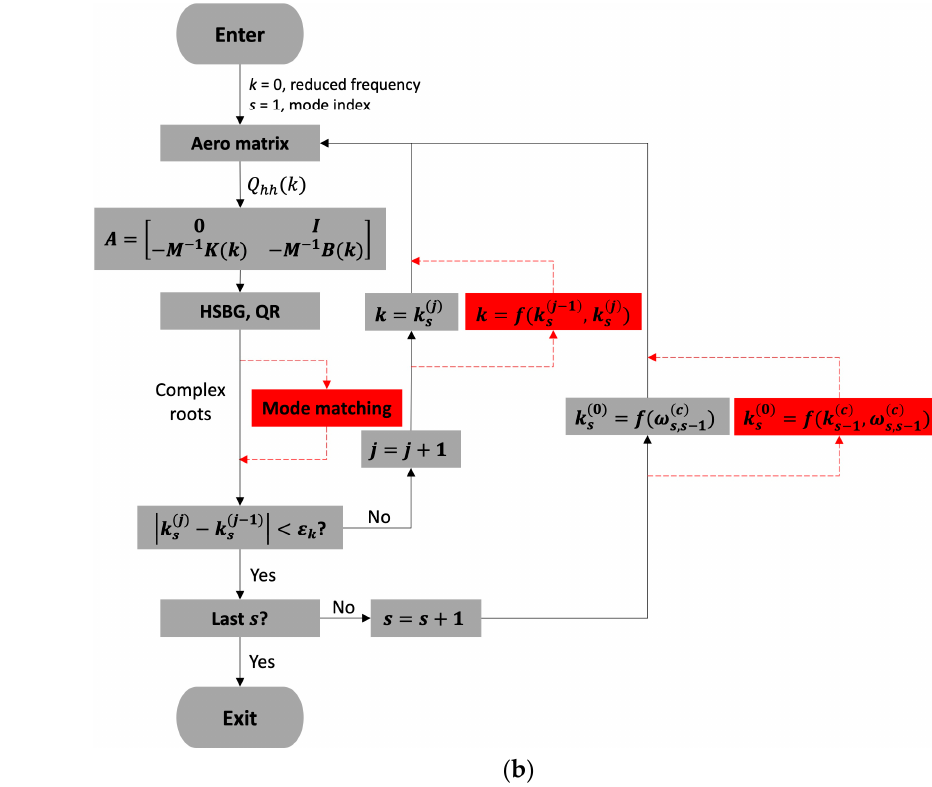
Figure 1. Flow chart of the PK-method, adapted from Bellinger [28]. The right plot ( b ) represents the PK-iteration process in the left plot ( a ). Grey: original processes in NASTRAN; Red: developments in this study.